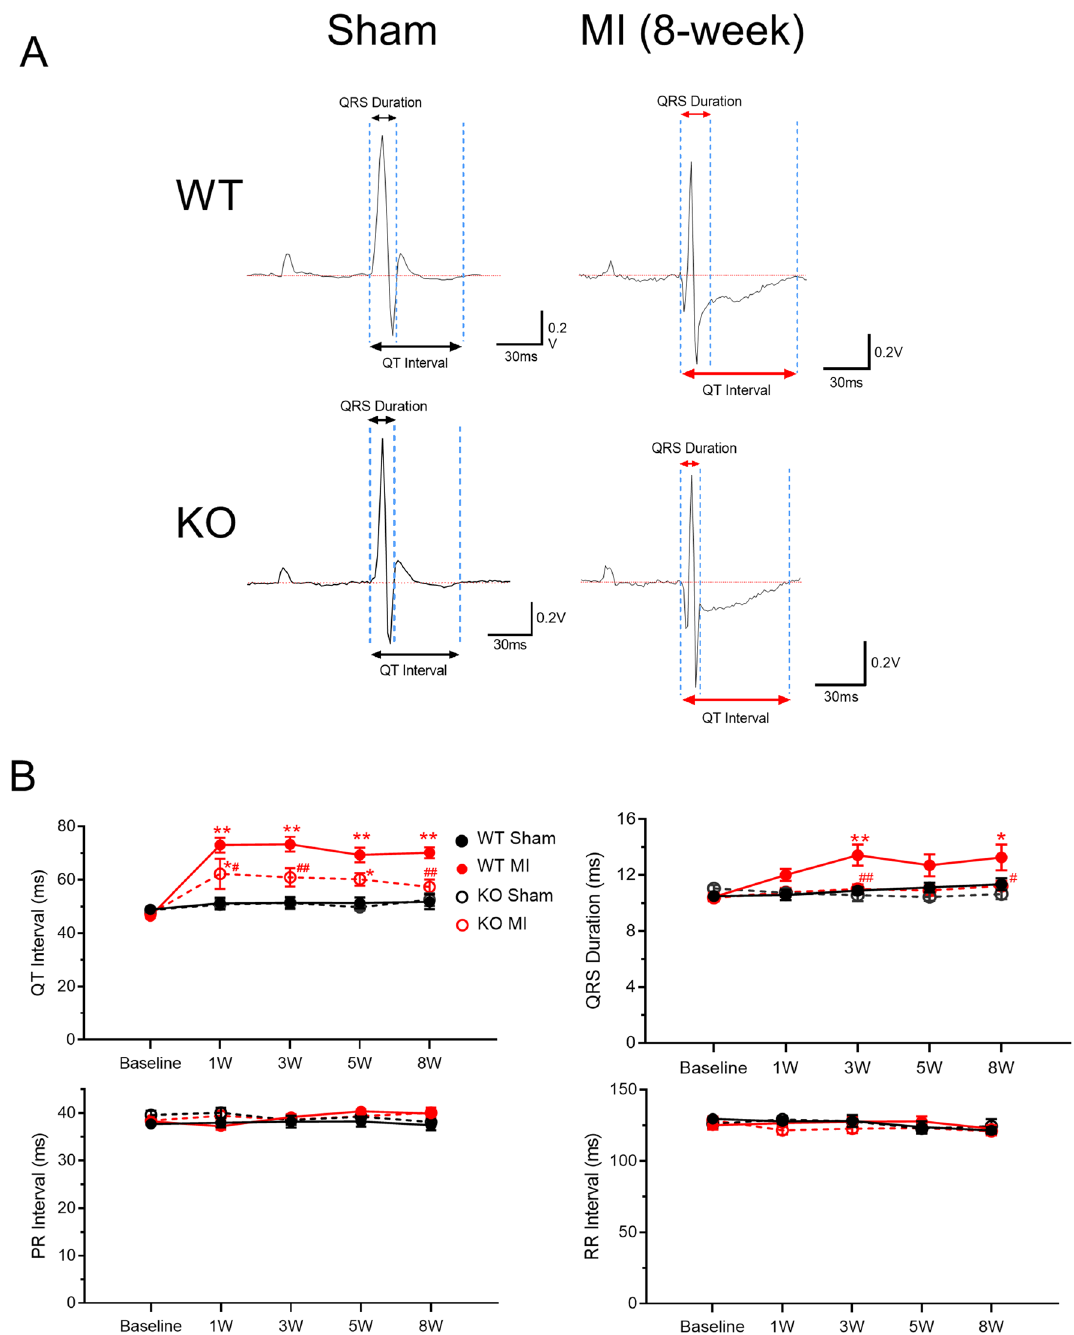
Figure 2. β-catenin knockout reduces the prolongation of QRS duration and QT interval after myocardial infarction. ( A) Representative in vivo surface ECG traces (Lead II) in sham mice (left) and in mice at 8 weeks after MI (right). ( B) Summary of in vivo ECG parameters, including QT Interval (top left), QRS duration (top right), PR Interval (bottom left), and RR Interval (bottom right). n = 10–13 per group. * p < 0.05, ** p < 0.01, vs. corresponding sham groups; # p < 0.05, ## p < 0.01, vs. WT MI group at the indicated timepoints. Data were analyzed by two-way ANOVA and Bonferroni post-hoc